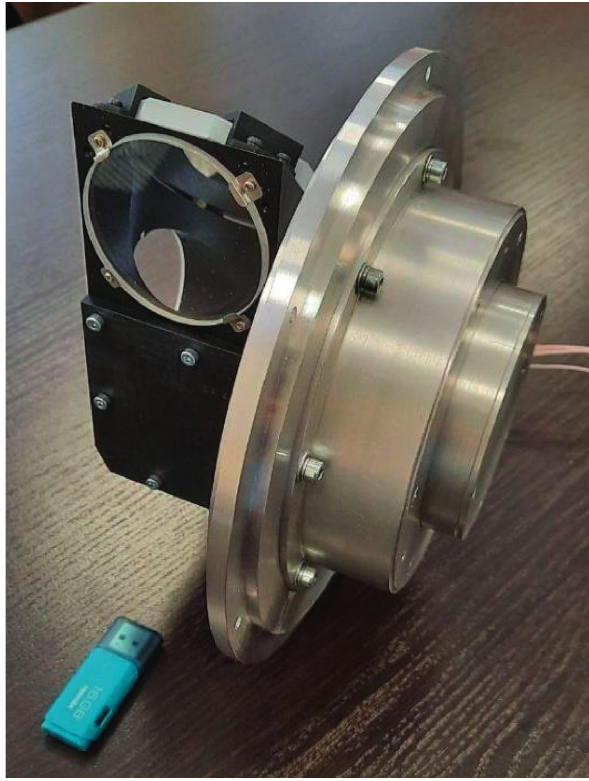
Figure 15: General view of the